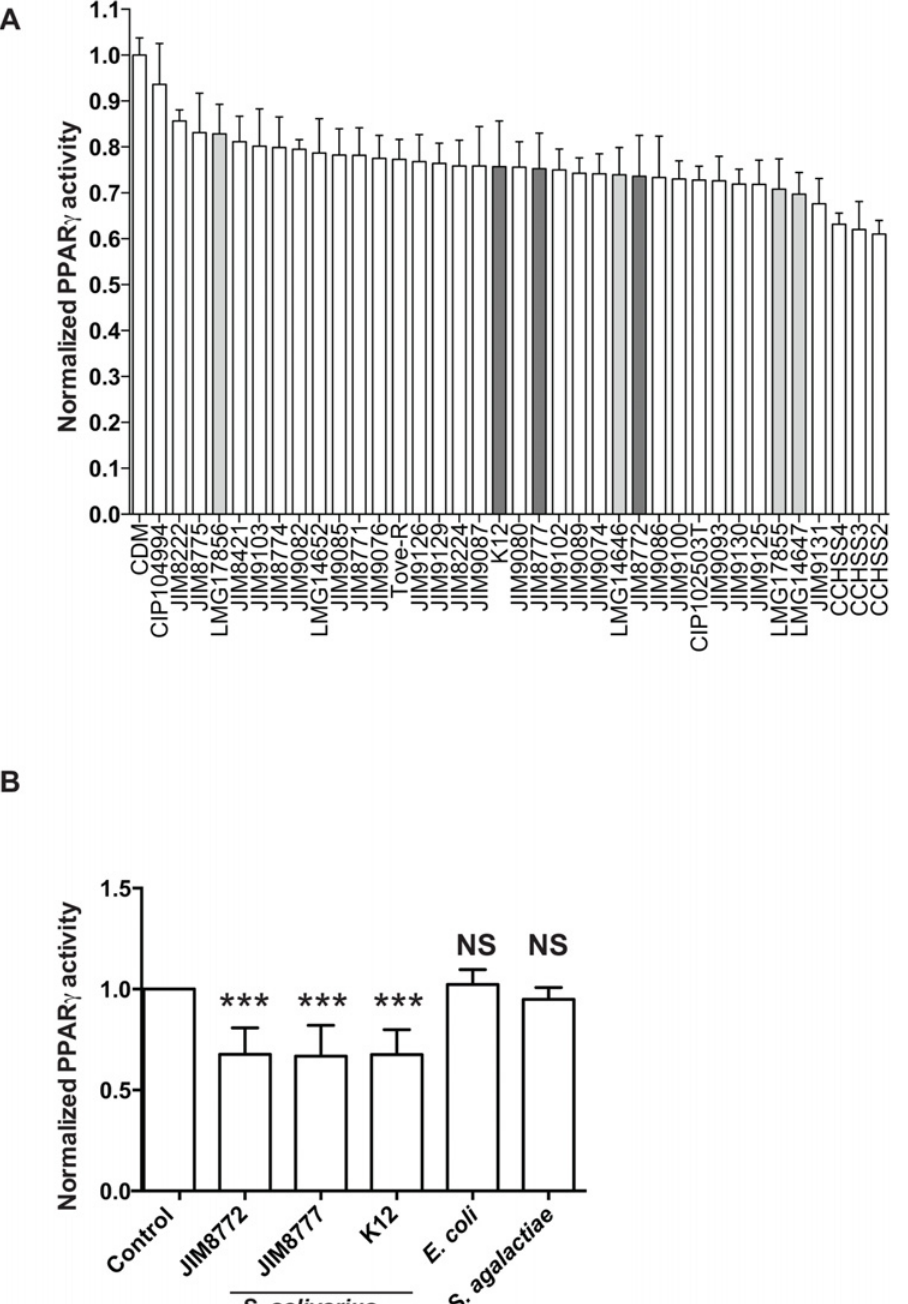
Fig 1. S . salivarius and S . vestibularis , but not S . agalactiae and E . coli , culture supernatants down-regulate butyrate-induced PPAR γ activity in HT- 29/PPAR γ . A- Culture supernatants of a wide range of S . salivarius (white bars) and S . vestibularis (grey bars) strains were applied on HT-29-PPAR γ (10% vol/vol) prior to PPAR γ -induction by sodium butyrate (But, 2mM) for 12h. PPAR γ transcriptional activity was measured by luciferase activity and expressed as fold increase towards its control: growth-medium + butyrate. Data are expressed as means ± standard deviations (SD) of triplicate measurements from one representative experiment out of three independent experiments. The dark grey bars represent the selected S . salivarius strains used for the remaining of the study (JIM8772, JIM8777 and K12). B- Culture supernatants of three S . salivarius (JIM8772, JIM8777 and K12), E . coli and S . agalactiae strains were applied on HT-29-PPAR γ (10% vol/vol) prior to PPAR γ -induction by sodium butyrate (2mM) for 12h. PPAR γ expression was measured by luciferase activity and expressed as fold increase towards growth-medium + sodium butyrate (Control). Data are expressed as means ± standard deviations (SD) of triplicate measurements from one representative experiment out of three independent experiments. *** P < 0.001 compared with controls (Student's t-test).